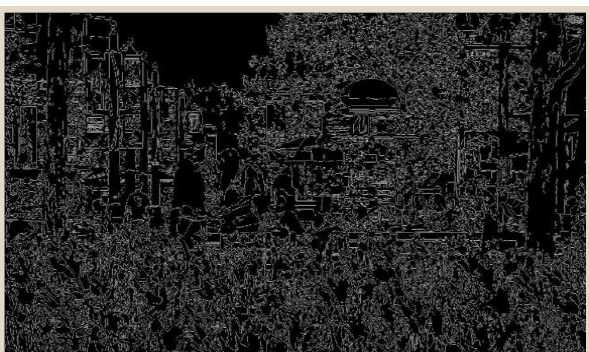
Figure 2. Spatial information